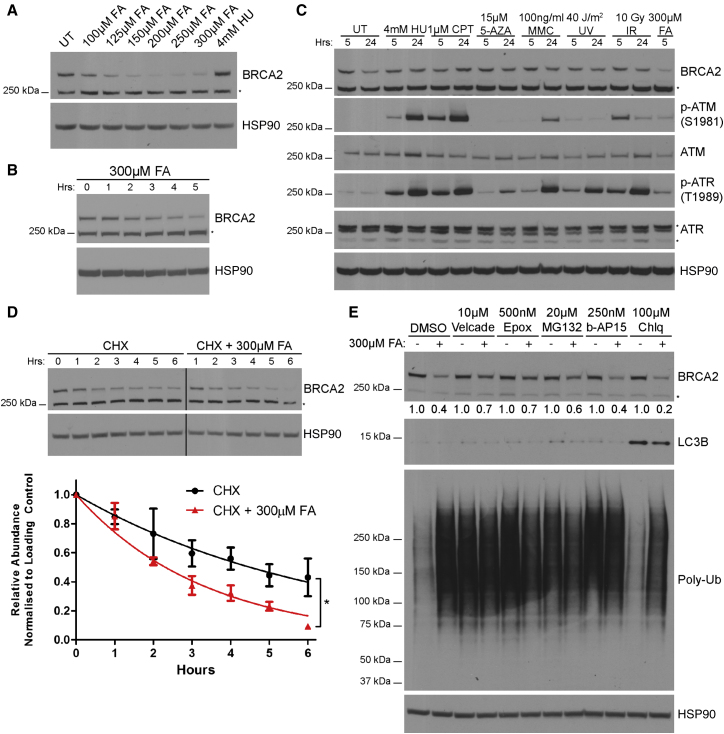
Selective Proteasomal Degradation of BRCA2 Protein after Formaldehyde Exposure(A) BRCA2 protein levels in wild-type HeLa Kyoto cells after 5-hr treatments.(B) BRCA2 protein levels in wild-type HeLa Kyoto cells treated as indicated.(C) BRCA2 protein levels in wild-type HeLa Kyoto cells treated with various DNA damaging agents for the indicated durations. HU, hydroxyurea; CPT, camptothecin; 5-AZA, 5-azacytidine; MMC, mitomycin C; UV, ultraviolet; IR, ionizing radiation; FA, formaldehyde.(D) BRCA2 protein turnover in wild-type HeLa Kyoto cells treated with or without 300 μM FA. Mean ± SEM of BRCA2 band intensities normalized to loading control and 0 hr, n = 3. CHX, cycloheximide.(E) BRCA2 protein levels in wild-type HeLa Kyoto cells pre-treated with various inhibitors for 3 hr prior to addition of 300 μM FA for 3 hr. Normalized BRCA2 band intensities are shown below. Results represent two independent experiments. Epox, epoxomicin; Chlq, chloroquine.See also Figure S3.